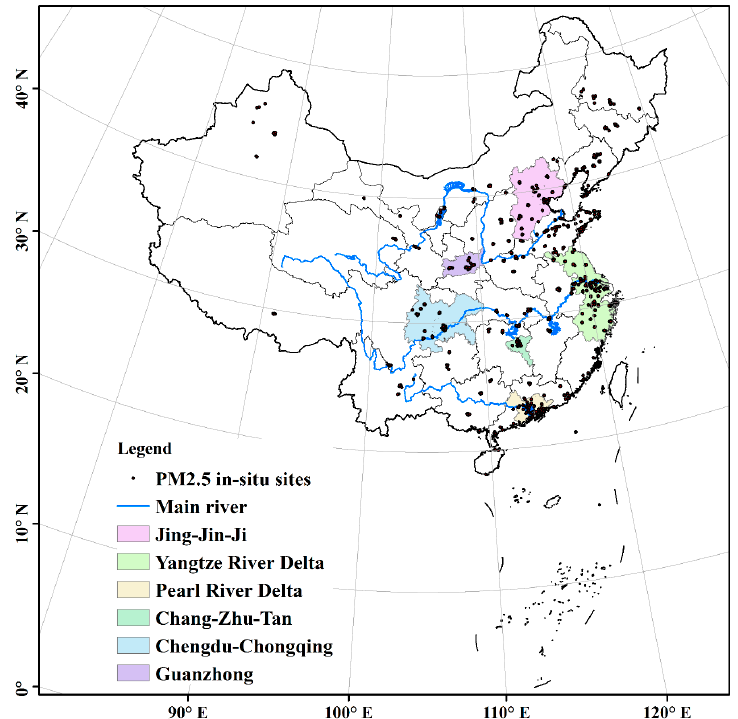
Figure 1. Study area.